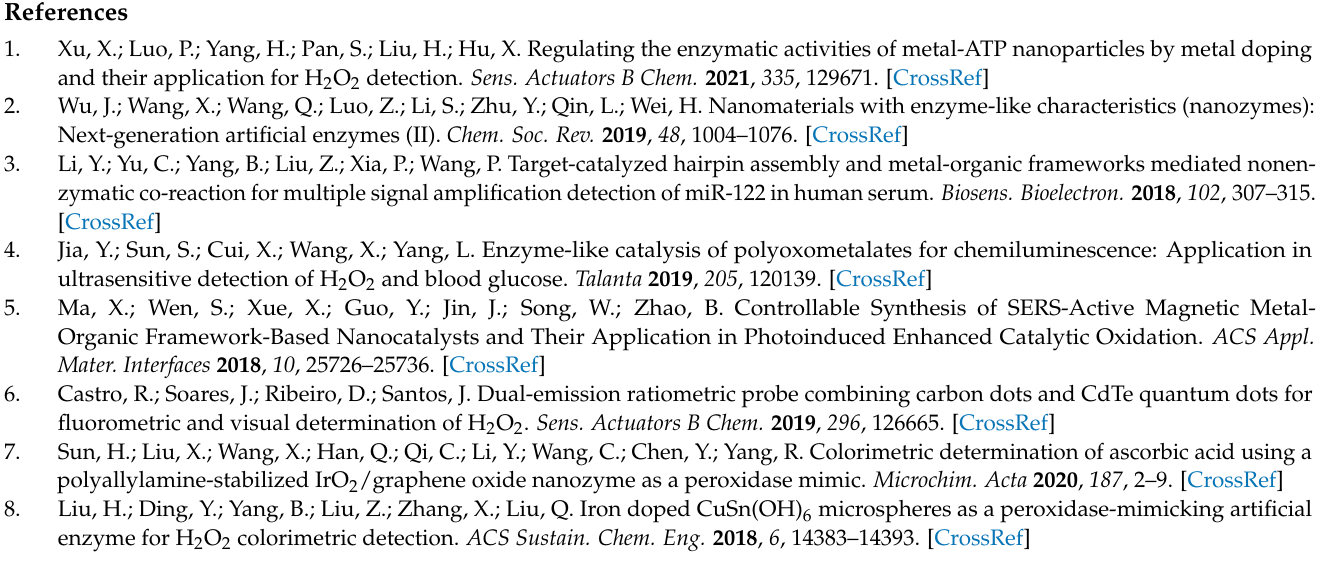
Table S2: Comparison detection limit in different catalyst systems by means of different